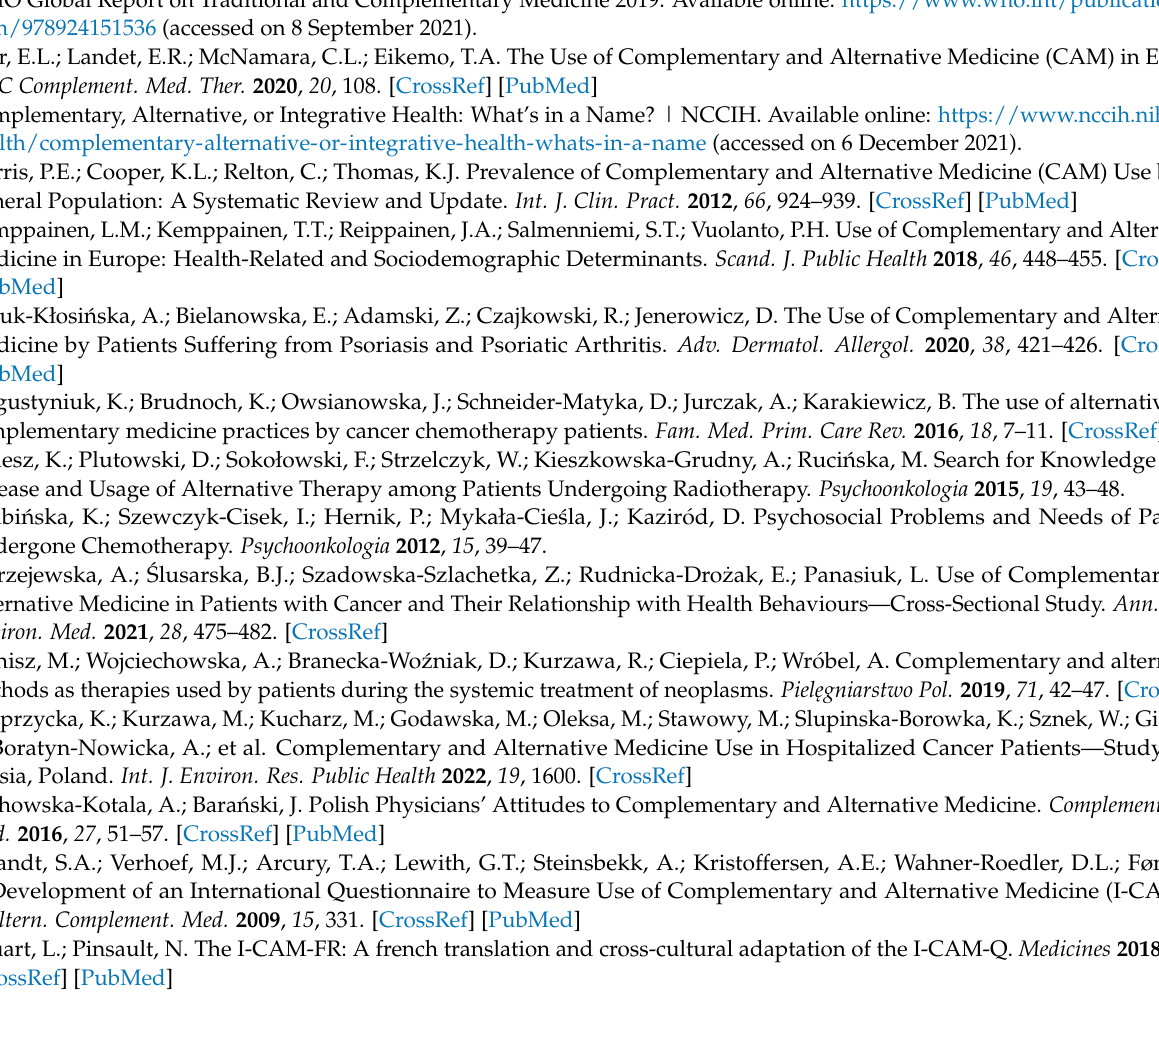
Facebook.; Table S2: STROBE Statement—Checklist.; Table S3: the results of the agreement in the assessment of the individual items of the I-CAM-Q scale by the experts using the Delphi method.; Table S4: the frequency, motivation and evaluation of herbal medicine and dietary supplements use in the study group during the last 12